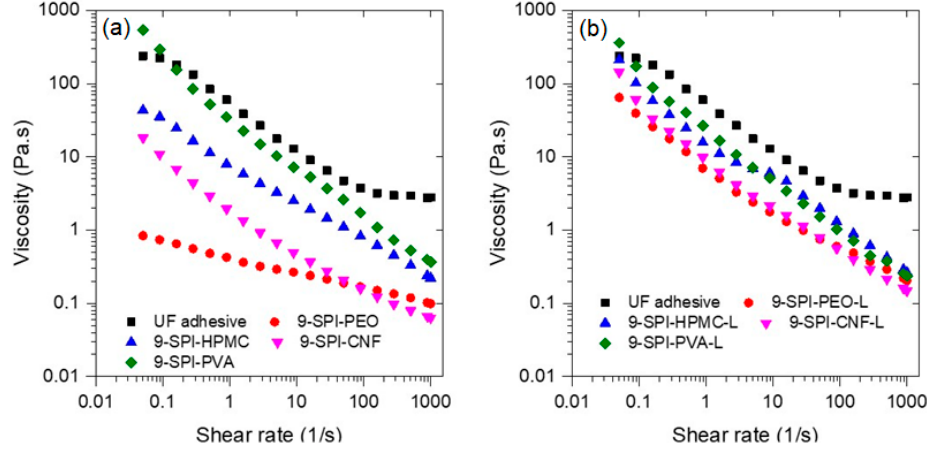
Figure 4. Flow rheology of studied adhesive soy protein isolate formulations ( a ) without and ( b ) with lignin.